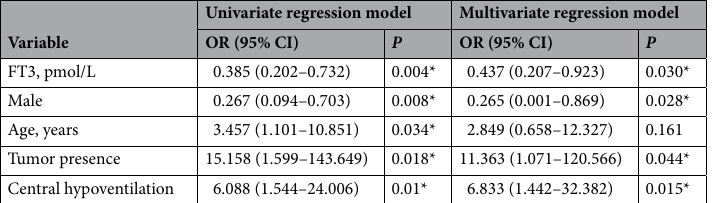
Table 4. Univariate and multivariate logistic regression analysis of predictors obtained within 24 h of admission for poor one-year outcome. In the univariate model, the eligible variables obtained within 24 h of admission and the tumor presence were analyzed, and those identified as not predictors of poor one-year outcome ( P > 0.05) were not shown in this table. In the multivariate regression model, the predictive value of FT3 was adjusted by gender, age, the tumor presence, and central hypoventilation within 24 h of admission. *Indicates P < 0.05. OR, odds ratio; CI, confidence interval; FT3, free triiodothyronine.